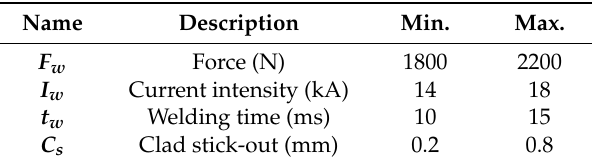
Table 2. Process parameter